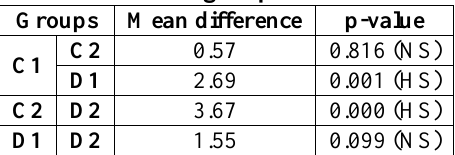
Table 4: Tukey HDS test of the tensile